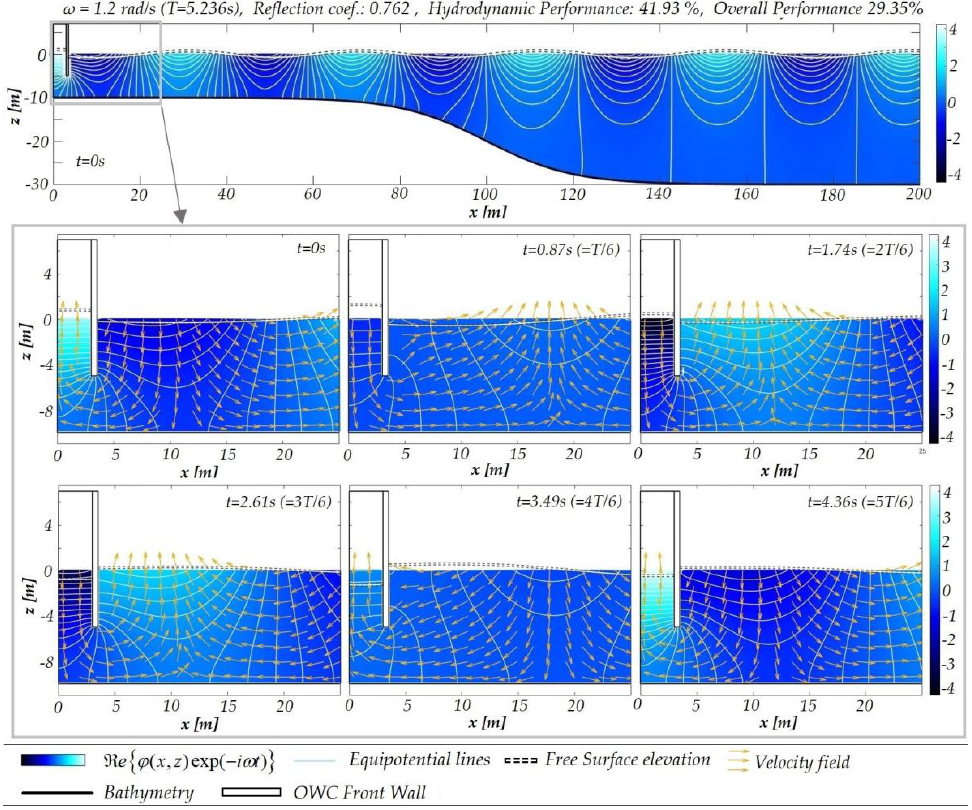
Figure 6. Equipotential lines of the wave field and free surface elevation at di ff erent time instants during an OWC’s operation in a variable bathymetry region ( Parameters : h a = 10 m , h b = 30 m , b = 3 m , d = 0.5 m , D = 5 m , (cid:101) λ = − 1.4, h c = 7 m κ = 0.05, δ h c ( x ) = 0 )